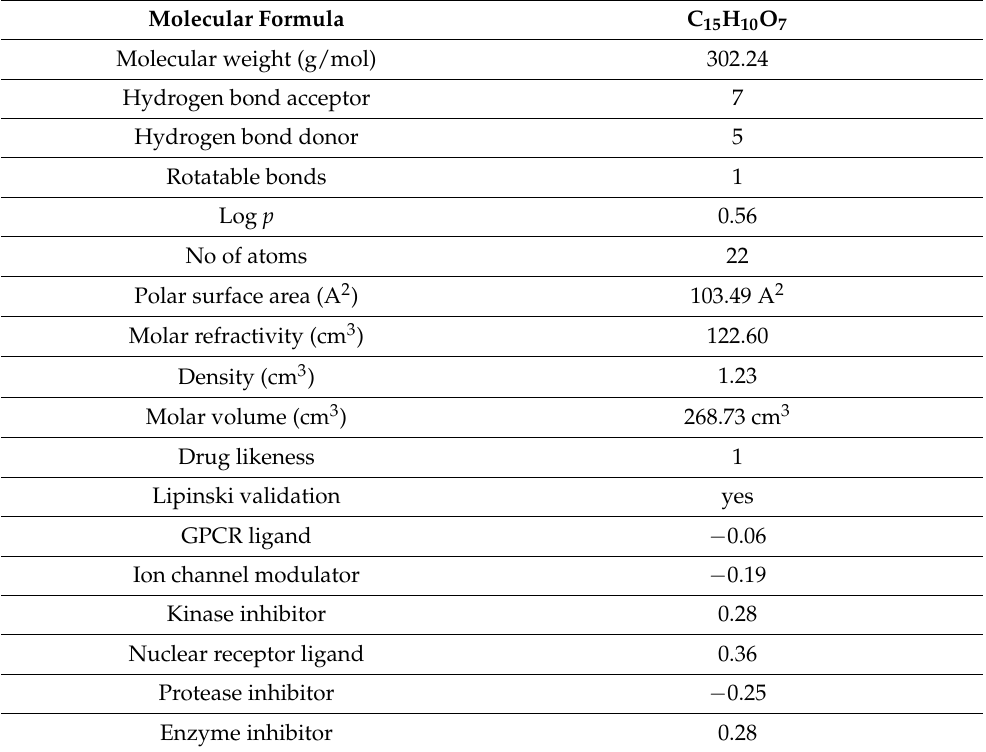
Table 7. Cheminformatics properties of